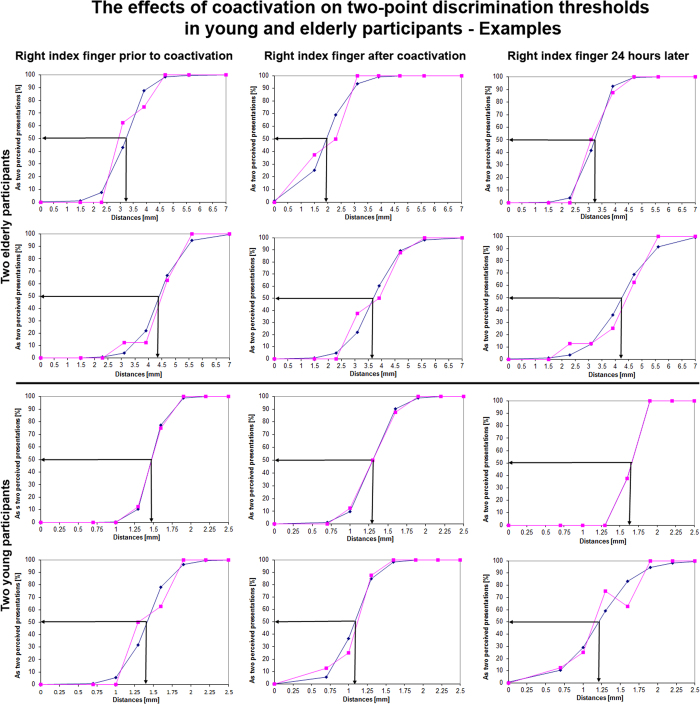
Coactivation effects on two-point discrimination threshold in two representative elderly and young participants.Note that the two-point discrimination thresholds in young participants after coactivation and 24 hours later were published elsewhere30 and did not enter any statistical analyses in the present work. These plots are only presented for comparison reasons (i.e., young vs. elderly participants). Shown are the as two perceived presentations in percent (x-axis) for the different tip distances (y-axis). The pink curve indicates participants’ decisions on the different pin distances and the blue curve indicates the fitted binary logistic regression (see Material and methods for further details). The two-point discrimination threshold was determined at the 50% criterion (see black arrows within each plot). Note that 3 hours of tactile coactivation had larger effects on the two-point discrimination thresholds in the elderly as compared to the young participants (see also the Discussion section in the main text for further information).